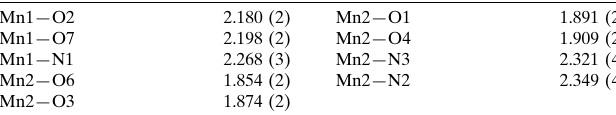
Selected bond lengths (A˚ ).